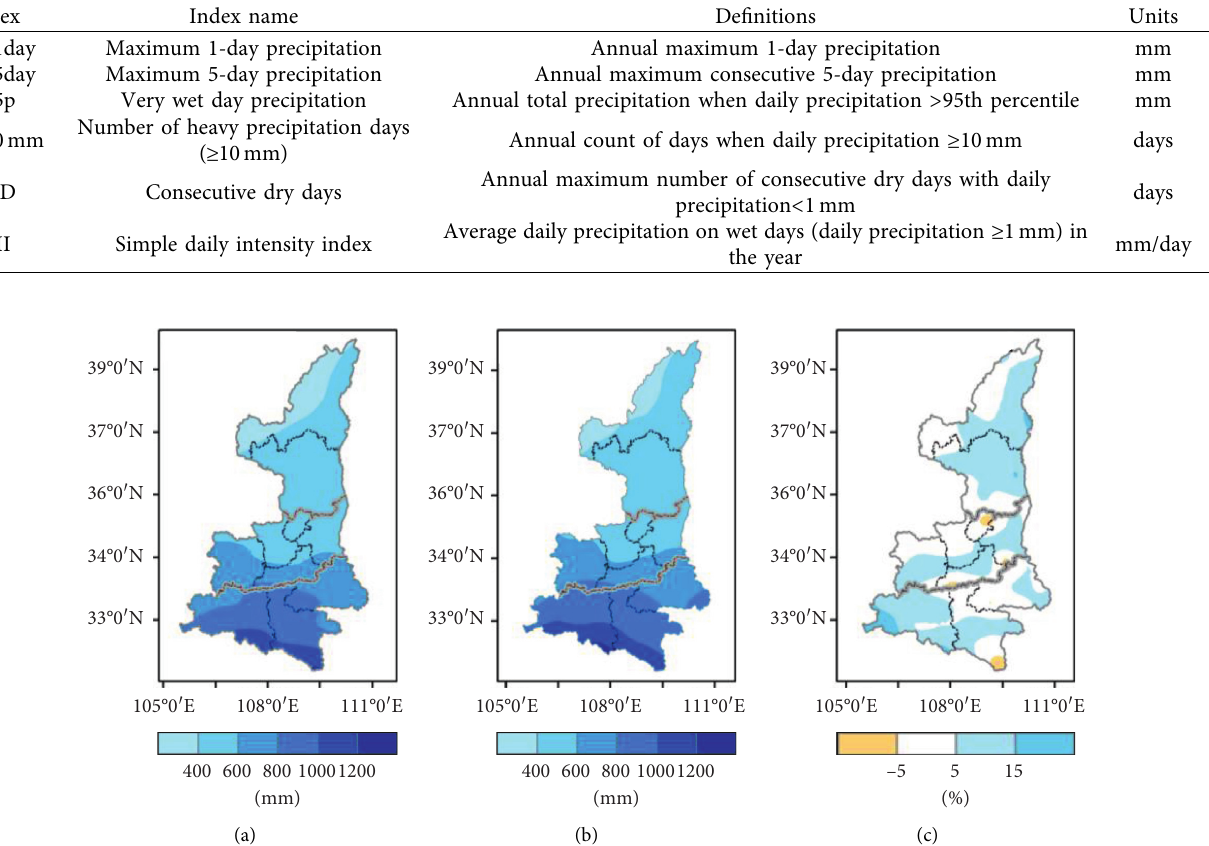
Table 1: Definitions of six extreme precipitation indices (EPIs) used in the study.